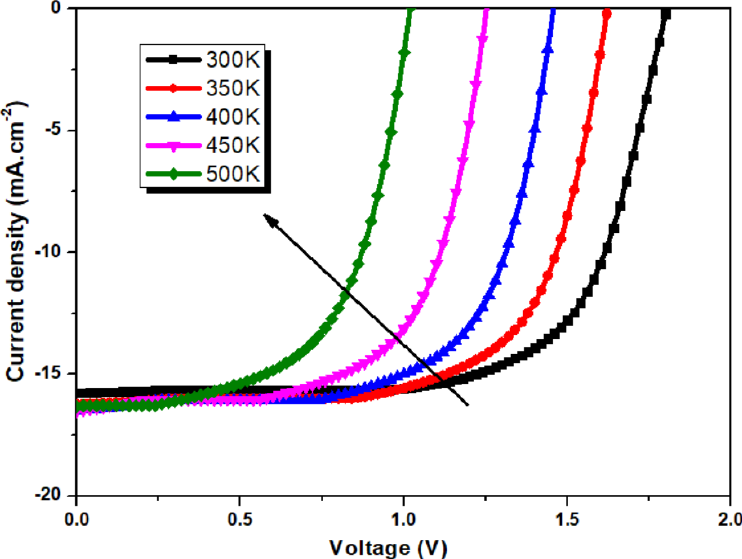
Figure 17. Effect of the working temperature on the J–V curve of the tandem solar cell.